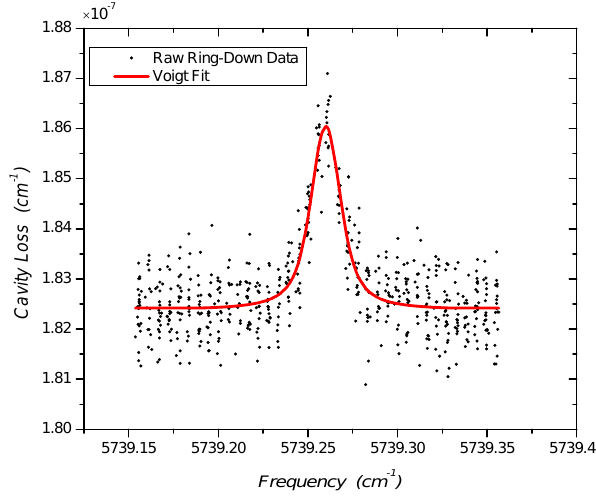
Fig. 4. Example plot of the measured cavity loss values versus frequency in the vicinity of the HCl absorption feature after 30 seconds of acquisition time. The red line is a Voigt profile fit to the ∼ 600 data points. The non-zero baseline is due to the empty cavity loss. The measured HCl concentration in this case is 6.25 ppbv.